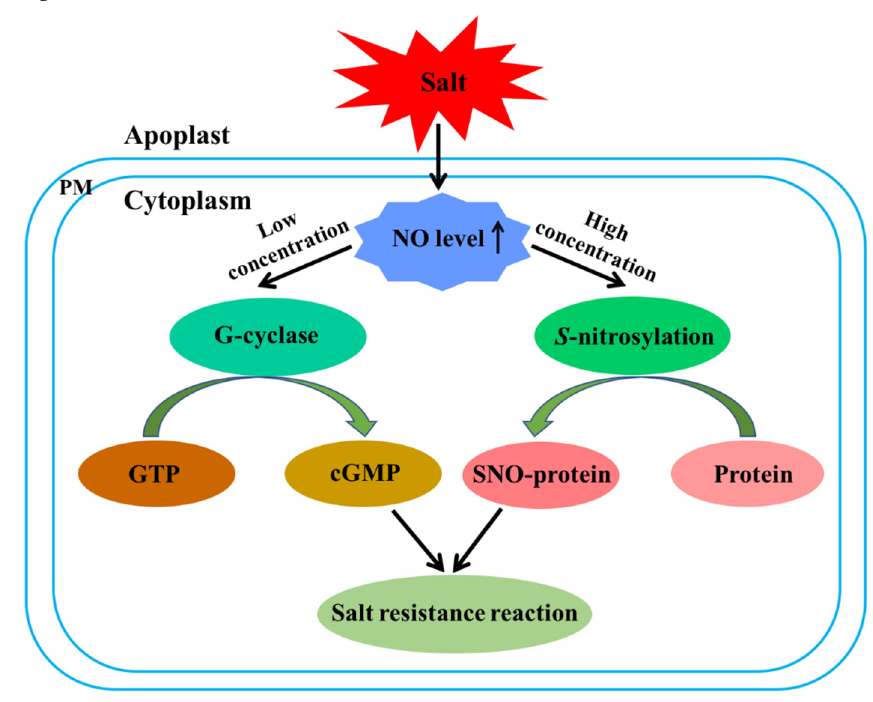
Figure 2. The molecular mechanisms of NO-mediated salt tolerance in